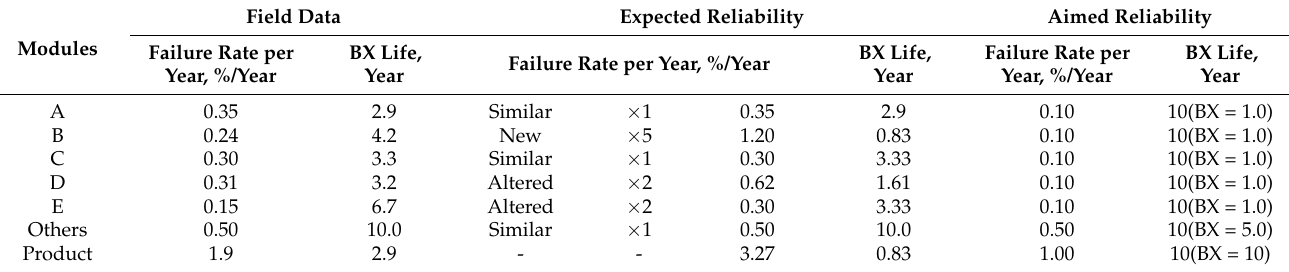
Table 1. Whole ALT scheme of mechanical modules in a refrigerator.